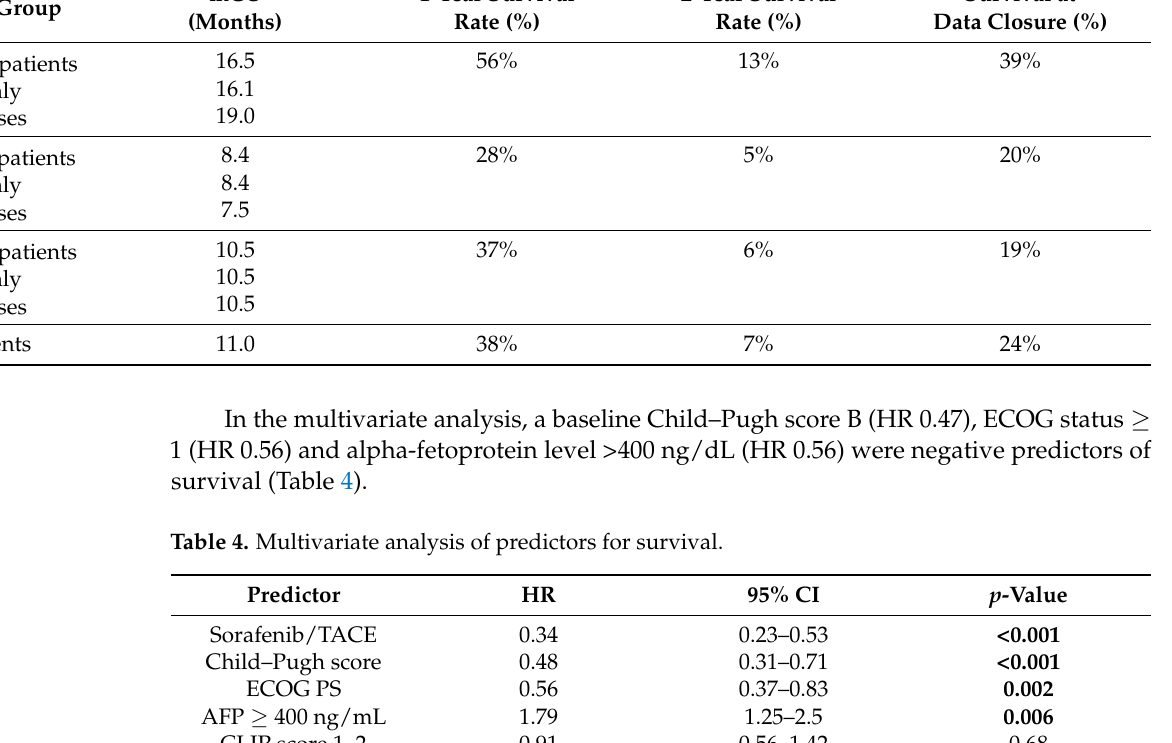
Figure 3. Overall survival. Table 3. Survival according to treatment.